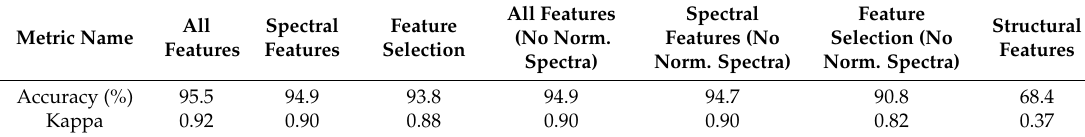
Table 12. Effect of different feature sets to classification using the k-NN method with k = 3.